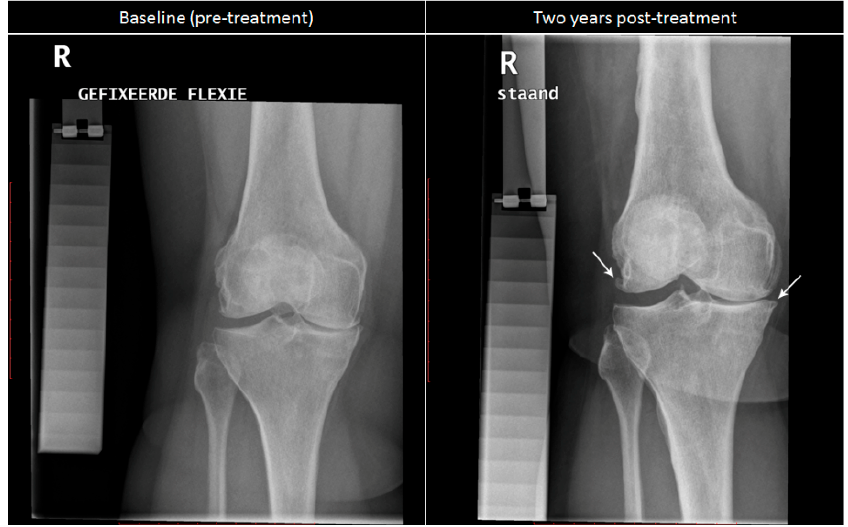
Figure 2. Representative radiograph of a patient before and two years after knee joint distraction treatment. Note the increase in osteophyte area over the two years as indicated by the arrows. None of the baseline characteristics, including gender, had a significant influence on the 2-year change in osteophyte size (all p > 0.32; Supplementary Table S3). As such, no